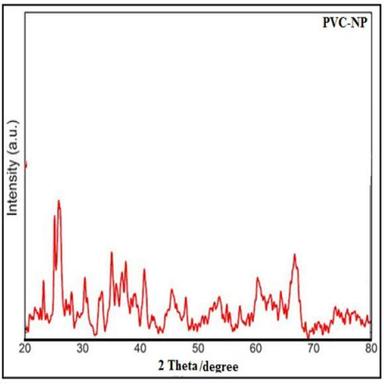
XRD spectra of PVC–NP composite material.